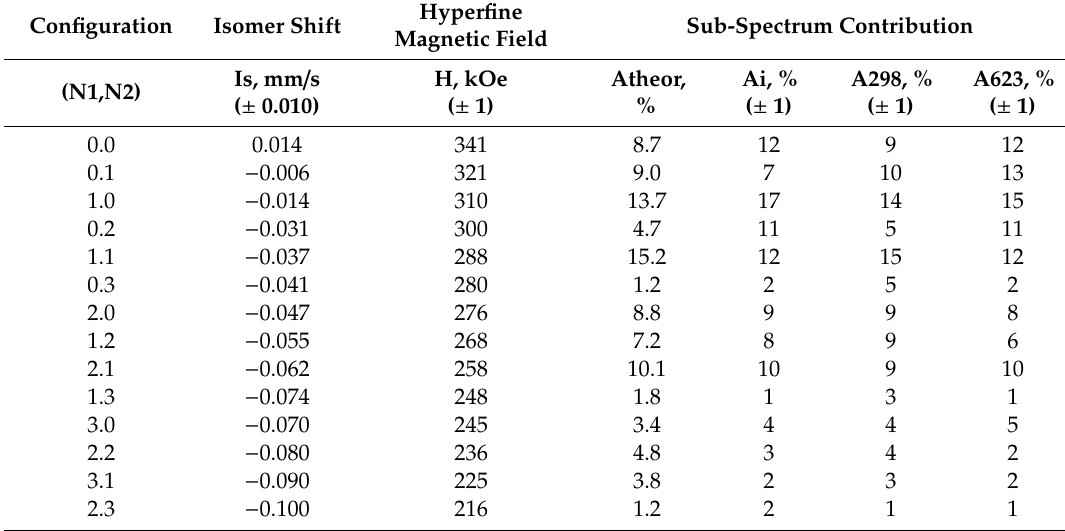
Table 2. Hyperfine parameters* and contributions of subspectra for the Fe-16Cr alloy. Subspectra contributions are presented for random distribution ( A theor ), initial state ( A i ) and after HPT at 298 K ( A 298 ) and 623 K ( A 623 ).